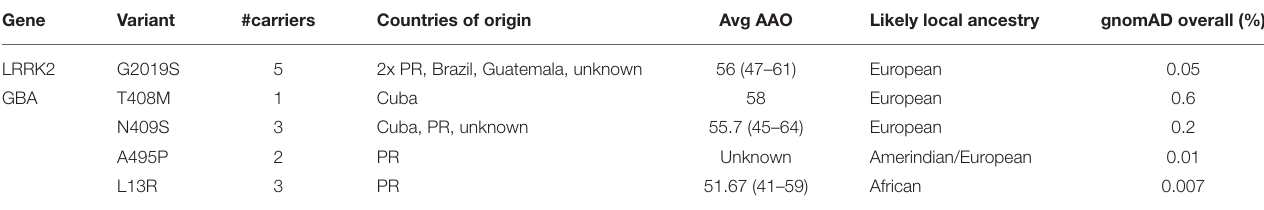
TABLE 2 | Known rare variants (MAF < 1%) identified in major exons of PD genes.